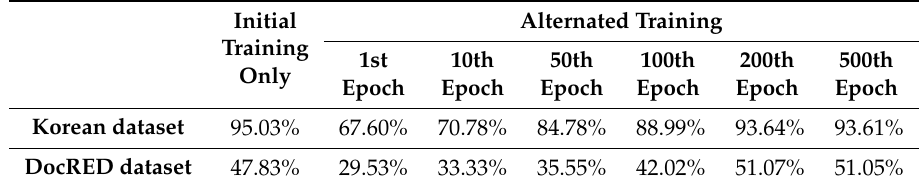
Table 1. Performance in the LSTM based Relation Extraction module during the process of alternated training.